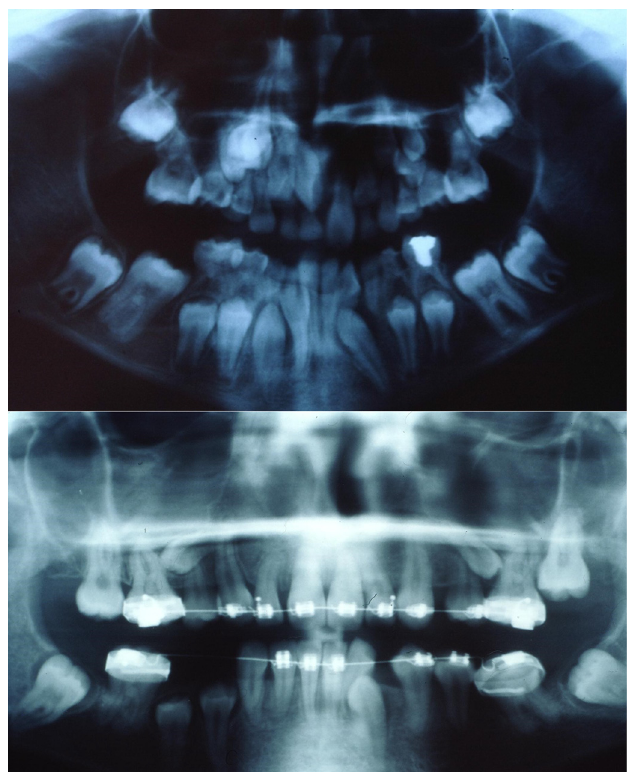
Fig. 4. Panoramic radiography of patient B at the beginning and the end of his treatment (age: 14 and 21 years).